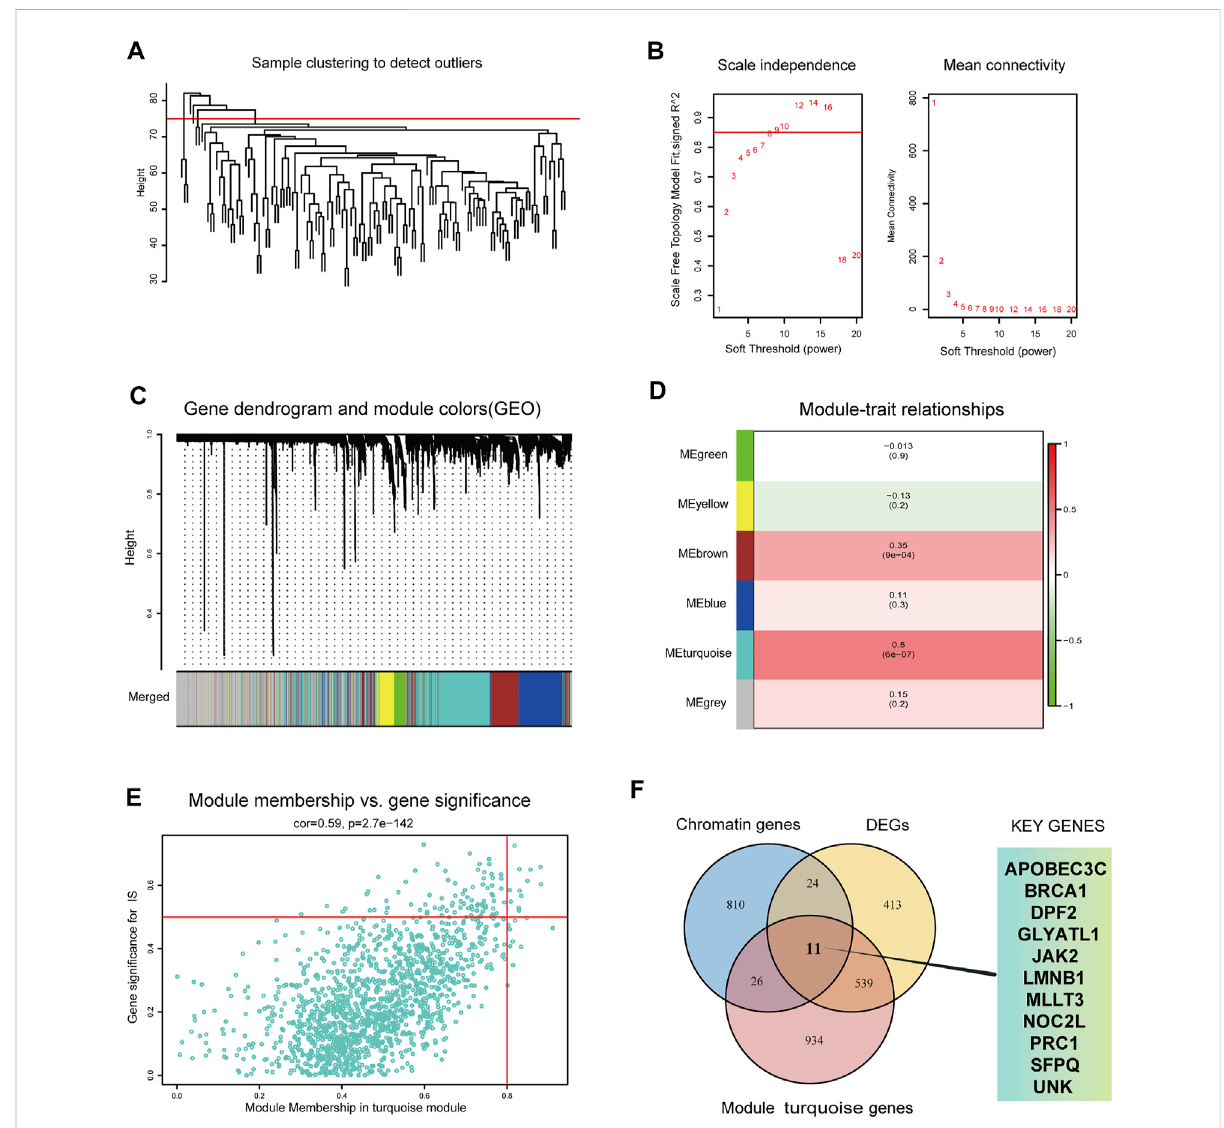
FIGURE 3 Identi fi cation of key modules genes and CRs related biomarkers (A) Outlier removal with “ h > 75 ” . (B) Soft threshold setting according to R2 = 0.85. (C) The gene set is divided into 6 different modules. (D) The correlation of modules with IS occurrence. (E) The correlation between turquoise module and IS gene signi fi cance. (F) The Venn plot of the three gene sets, DEGs, turquoise module genes and CRs-related